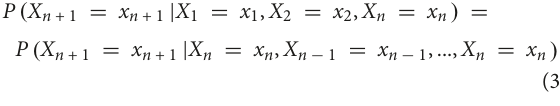
of Logitech 922c videocamera and screen), according to the video game. RTs were measured from the moment when the arrow appeared until the virtual/physical button was pressed. Recorded data were based on the keys pressed, the participant’s RT and whether or not the correct key